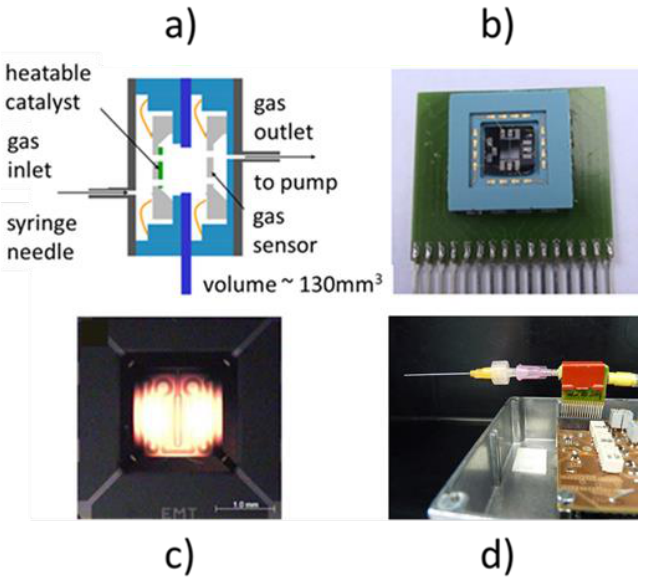
Figure 4. Enhanced micro-reactor system (EMRS); ( a ) cross section featuring embedded MOX gas sensor and heatable MEMS catalyst; ( b ) view onto MEMS micro-sensor; ( c ) view onto high-temperature heated catalyst; ( d ) EMRS mounted on printed circuit board featuring micro-pump and micro-reactor with hollow needle inlet and outlet hose connected to the pump.